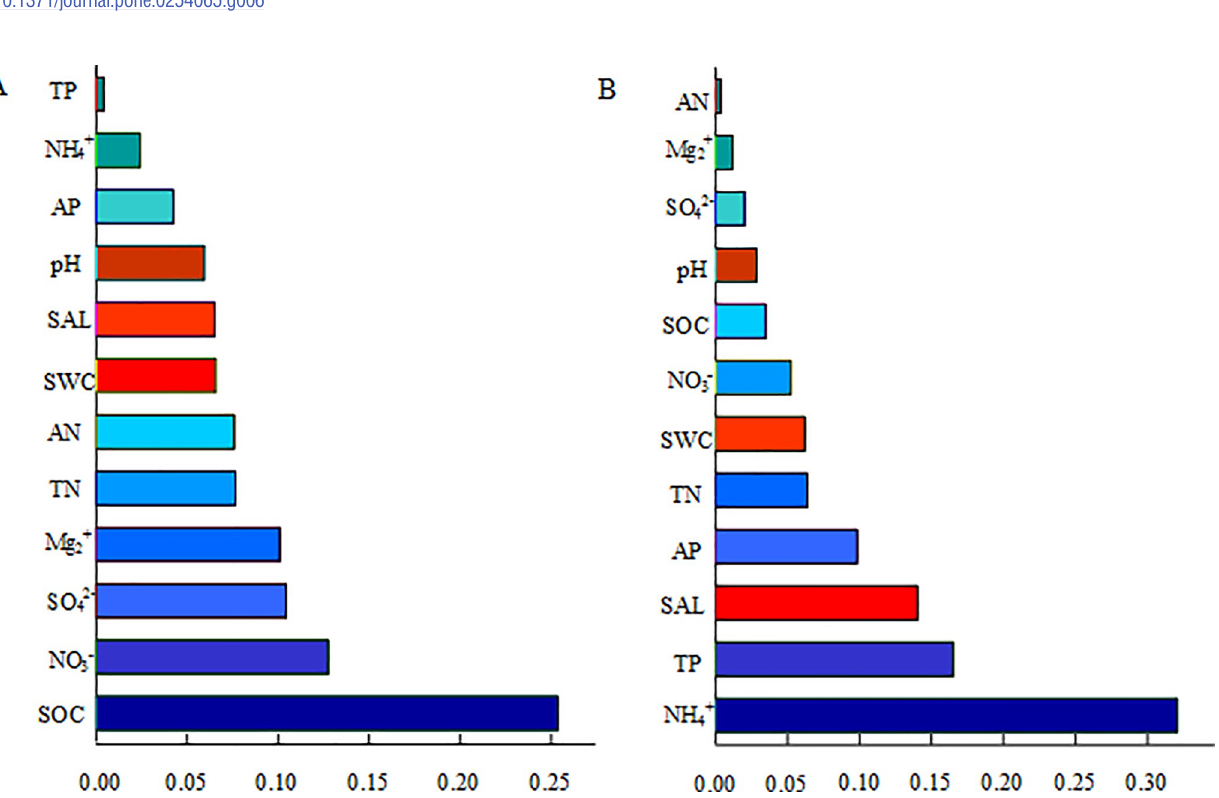
Fig 7. Sequence of the influence of environmental factors on soil microbial community structure of the bacterial community (A) and fungal community (B).